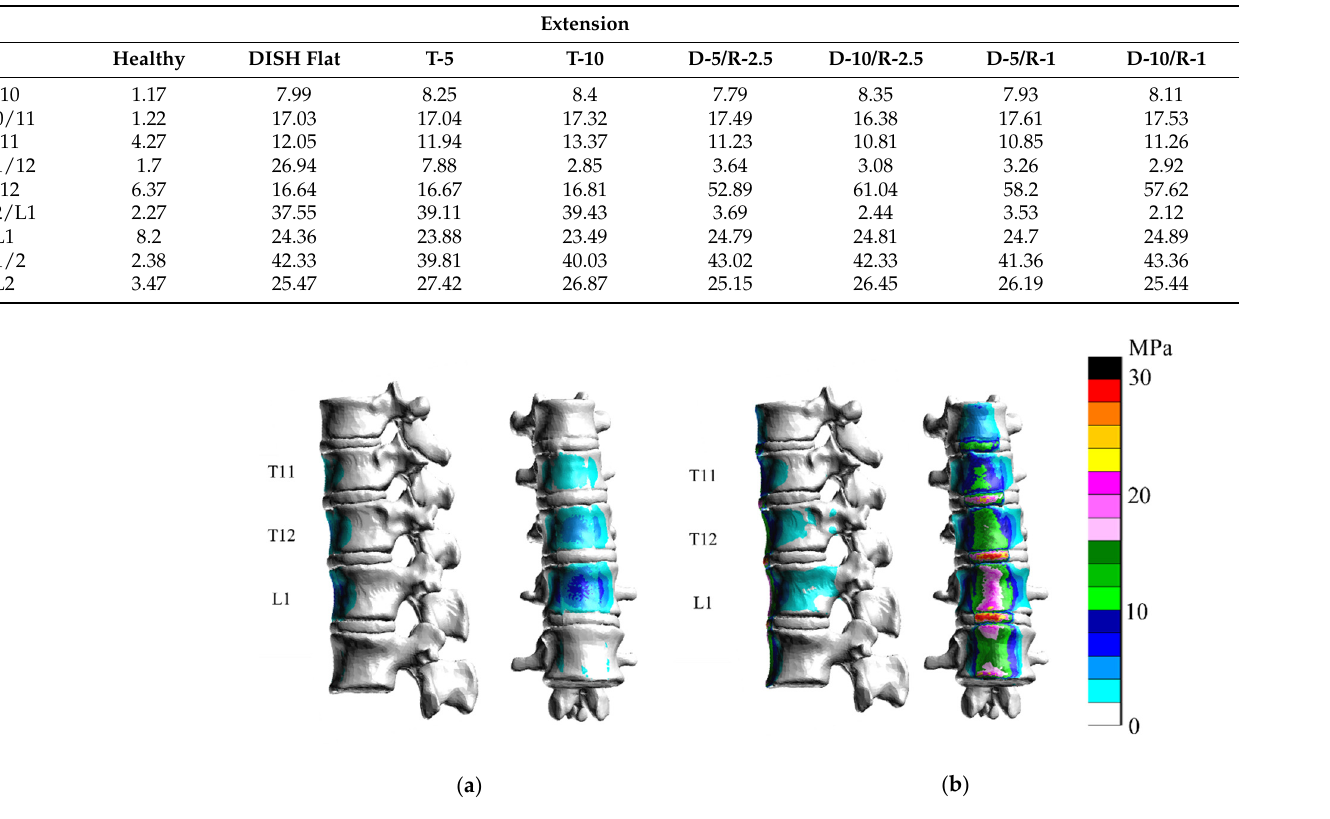
Figure 6. Only vertebral bodies and discs are shown for clarity. The right bar is color-coded according to stress (MPa). Stress diagrams of ( a ) the healthy model and ( b ) the diffuse idiopathic skeletal hyperostosis (DISH) flat model. Stresses were greater in the flat model in extension than in the healthy model.